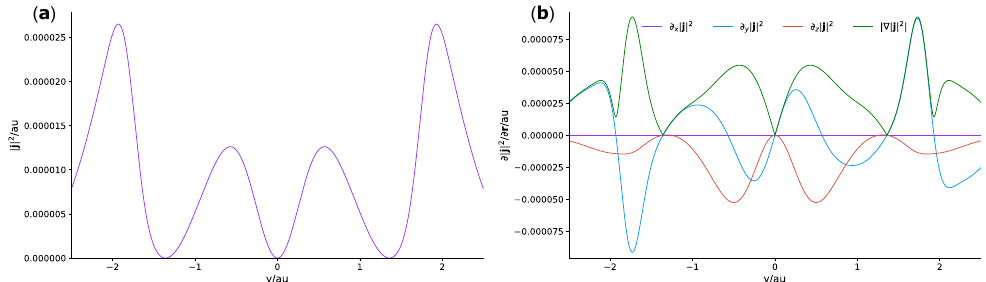
Figure 2. ( a ) The value of | j | 2 ; ( b ) The Cartesian gradient components ∂ γ | j | 2 and its magnitude plotted from y = − 2.5 to 2.5 bohr at z = 2.3 bohr in the ethene molecule in the yz -plane with a magnetic field of 0.1 B 0 along the z